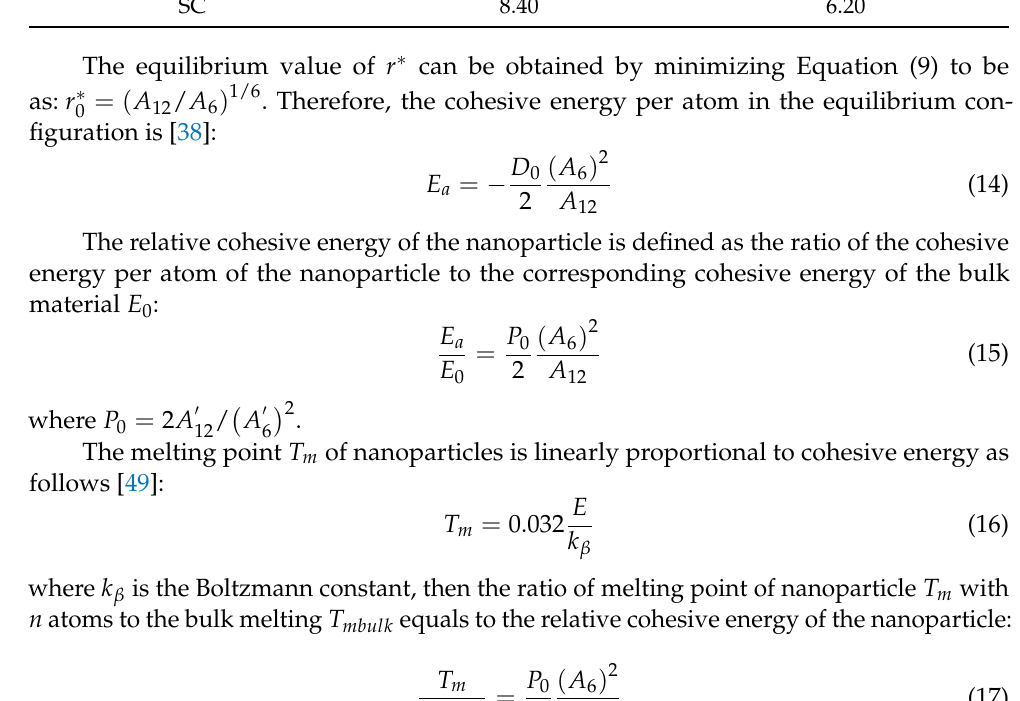
Table 2. The values of A (cid:48)